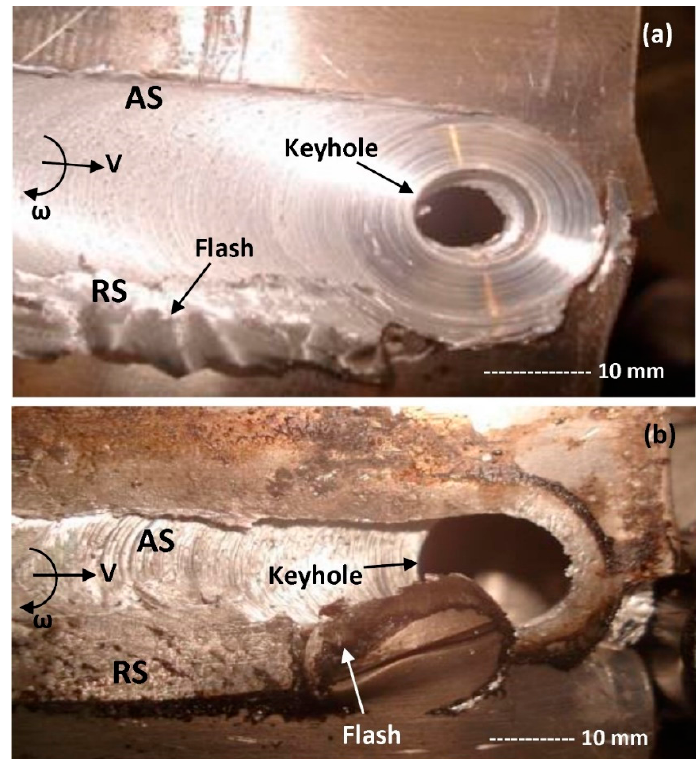
Figure 5. Surface appearance of the weld for conical FSW tool at constant RPM; ( a ) at welding speeds of (250 rpm and 710 mm/min) and ( b ) at welding speeds of (250 rpm and 1400 mm/min).